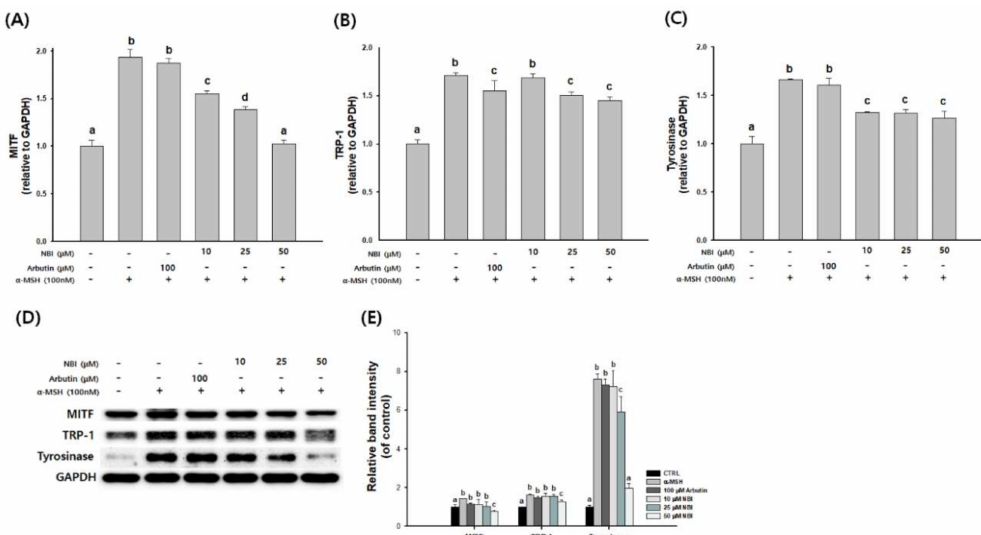
Figure 6. E ff ects of NBI on the expression of melanogenesis-related mRNA and proteins. B16F10 cells were treated with α -MSH and NBI at the indicated concentration. ( A ) MITF mRNA levels, ( B ) TRP1 mRNA levels, ( C ) tyrosinase mRNA levels, ( D ) MITF, TRP1, and tyrosinase protein expression levels, and ( E ) The graph indicates the expression level against GAPDH expression level. Data are presented as mean ± SD. Values with di ff erent letters (a, b, c, d) are significantly di ff erent one from another (one-way ANOVA followed by Tukey’s multiple range test, p < 0.05).